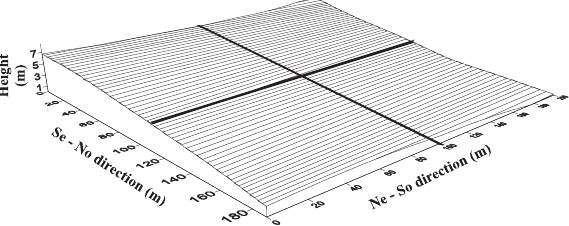
Figure 1. Three-dimensional representation of surface elevations and transects locations, across and along coffee